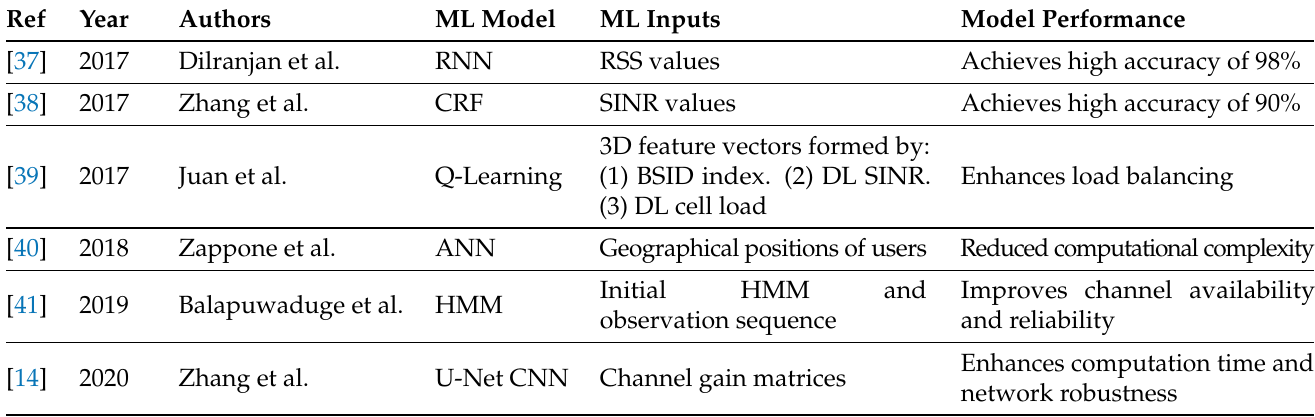
Table 1. A comparison among recent ML-based cell selection schemes.